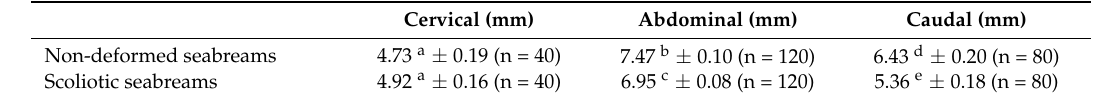
Figure 3. Longitudinal sections of vertebral collagen fibrils ( A ) from a scoliotic seabream and ( B ) from a non-deformed seabream. Vertebrae collagen fibrils’ periodicity (D) did not differ between seabream without any skeletal deformity and seabream with scoliosis. The Kolmogorov–Smirnov test was used for normality checking of the collagen fibrils’ period. Table 2. Seabreams’ vertebrae mean